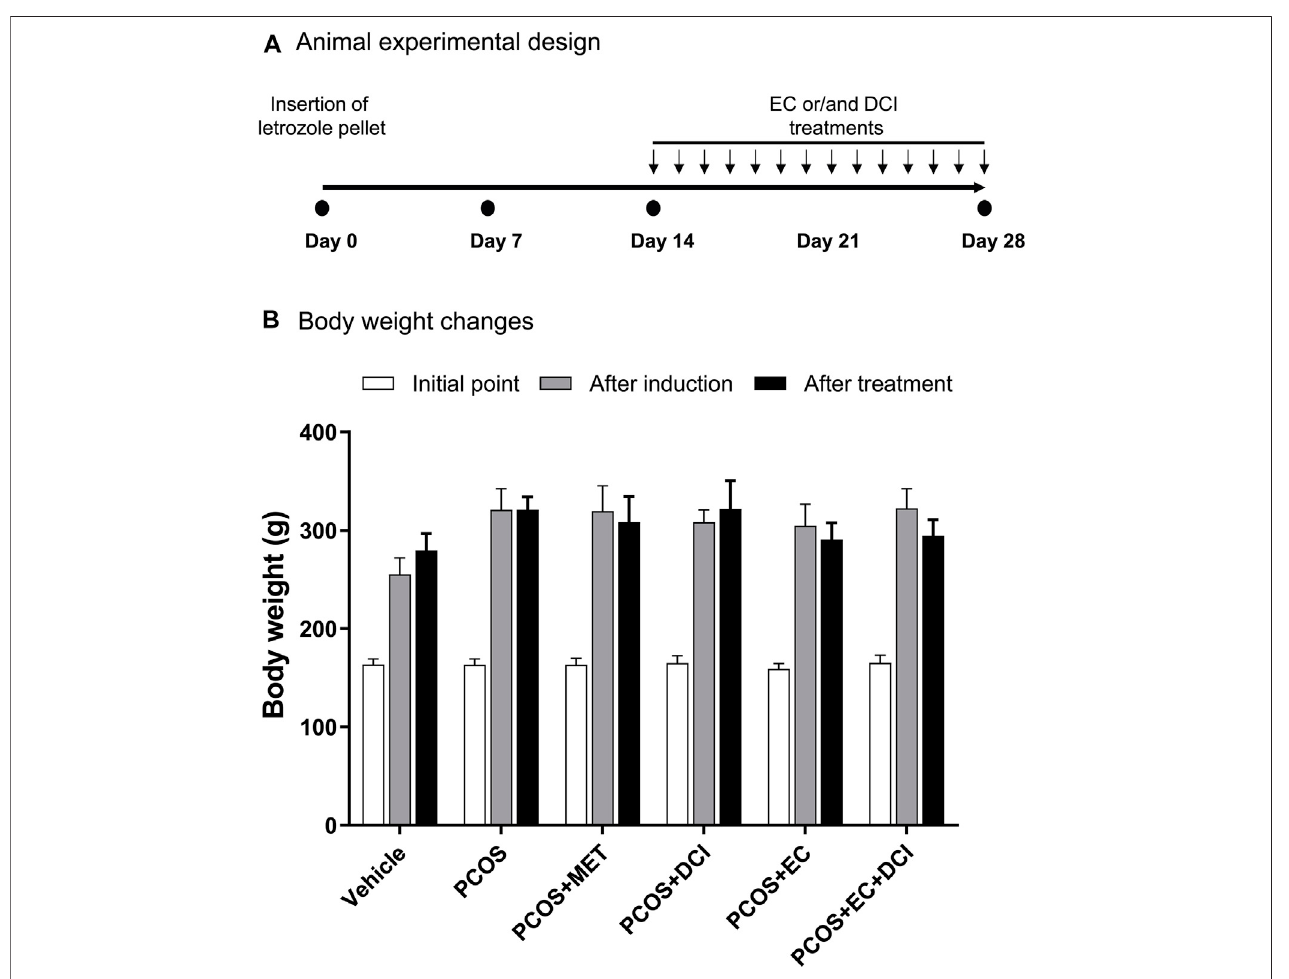
FIGURE 2 | Effect of EC extract DCI on body weight changes. (A) Animal experimental design. (B) The body weight(s) was measured after the start of the experiment, induction, and drug treatment. * p < 0.05 vs. initial point. MET, metformin; EC, Ecklonia cava K.; DCI, d-chiro inositol.